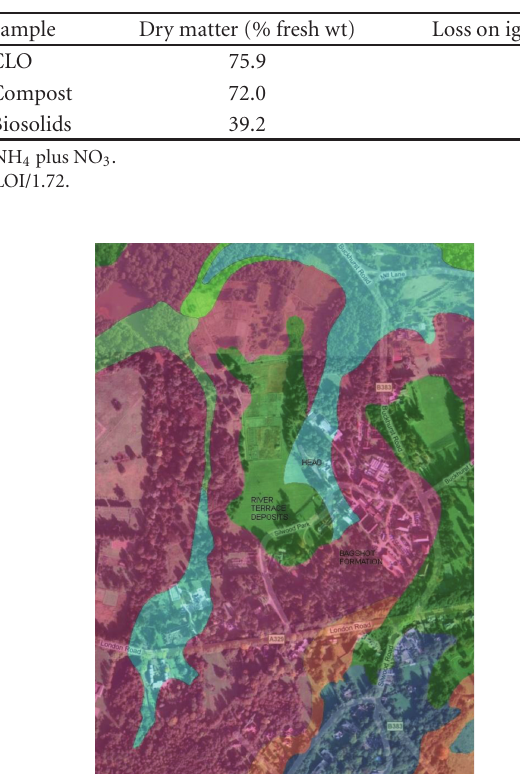
Table 3: Properties of samples, provided by suppliers.